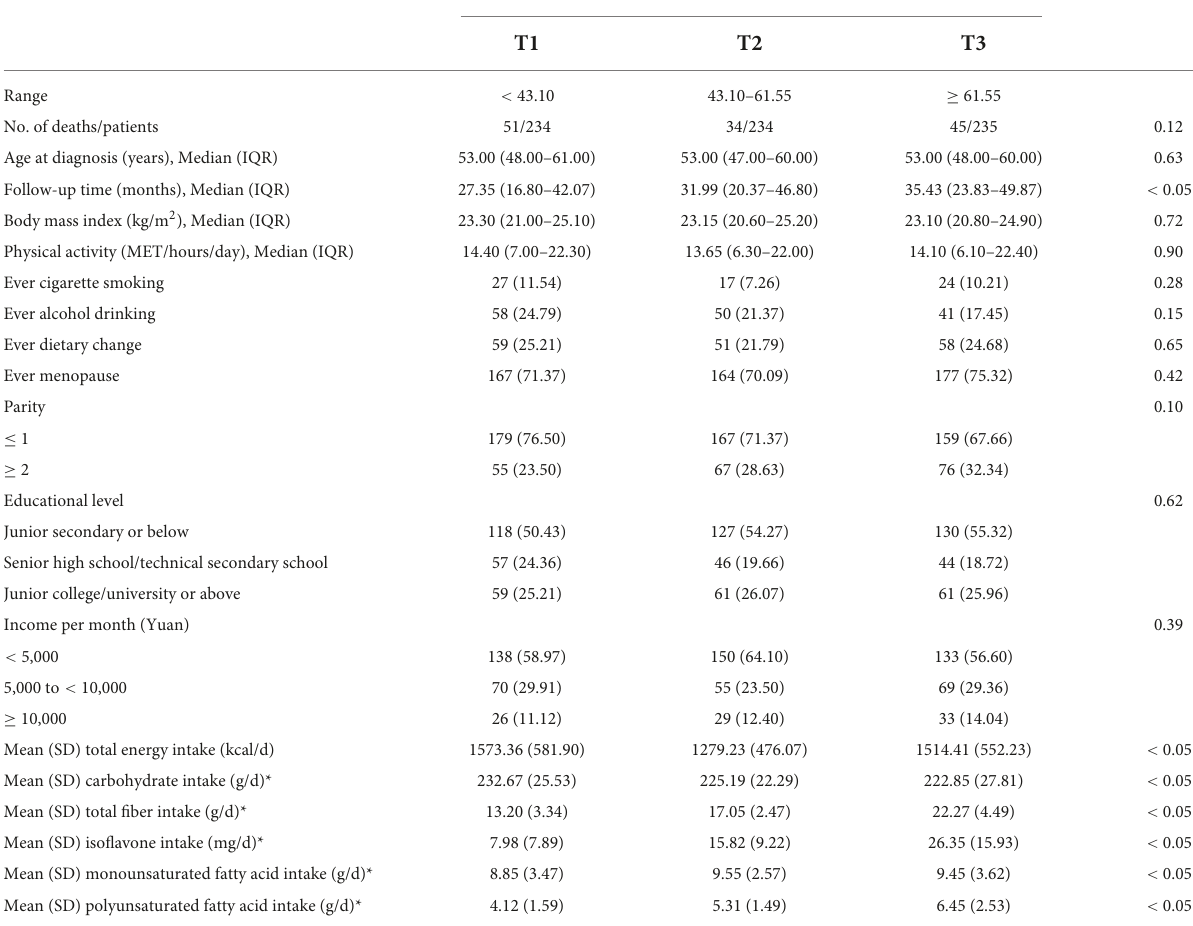
TABLE 1 Baseline characteristics of ovarian cancer patients by tertile of total phytosterols intake ( N = 703).